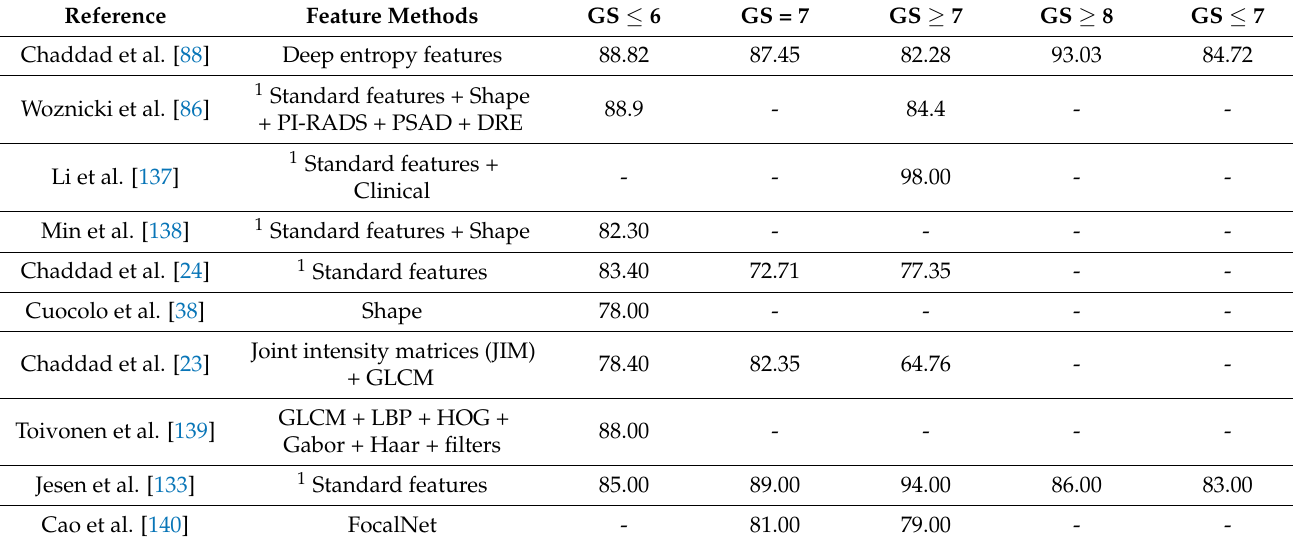
Table 2. Summary of the area under the ROC curve (AUC) value for recently published papers related to GS prediction using radiomic signature derived from mpMRI of prostate cancer